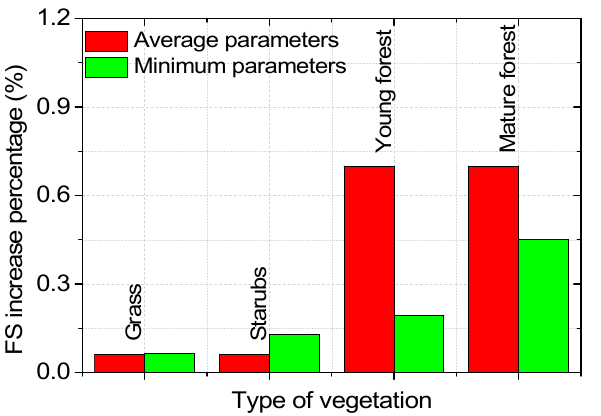
Figure 8. Relative increase of slope’s factor of safety with different vegetation reinforcement. The red column was determined using average soil strength parameters, but the green column was determined using minimum soil strength parameters.